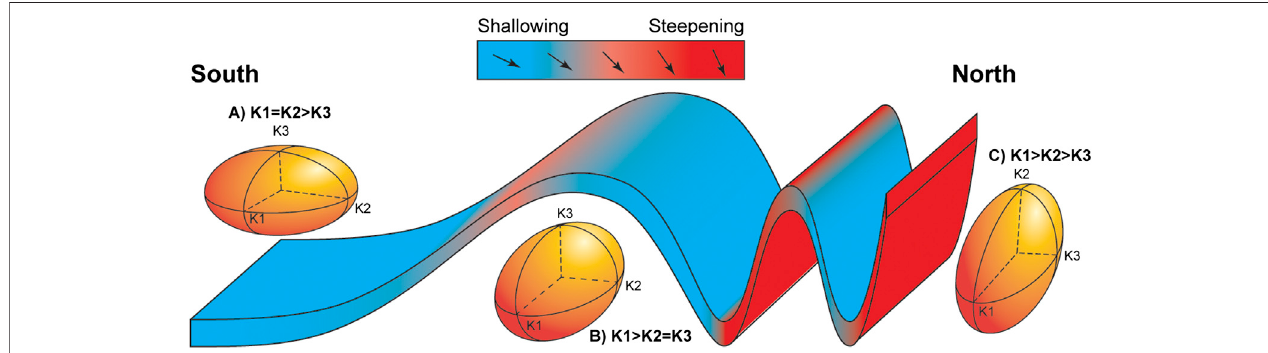
FIGURE 1 | Theoretical evolution of magnetic fabric in sedimentary rocks during incipient deformation. (A) Absence of fi nite strain results in the solely effect of compaction-derivedoblatefabric. (B) Duringa weakcleavage stagethefabricassumesaprolateshape,withthemajoraxisperpendiculartotheshorteningdirection. (C) In a strong cleavage state the fabric is triaxial, with the minor and major axes respectively parallel and perpendicular to the shortening direction. The effect of the fabric evolution on the paleomagnetic inclintaion is shown on top of the fi gure; fi gure drawn adapting concepts from Parés et al., 1999 and Borradaile, 1997.